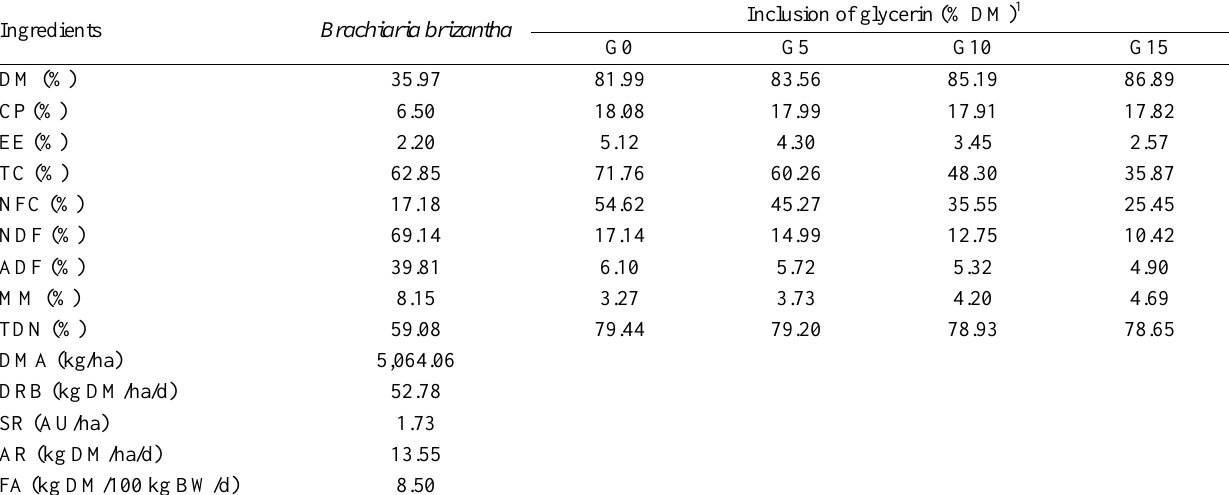
Table 2. Chemical composition of the Brachiaria brizanta cv. Marandu and of the concentrates (% of DM), total dry matter availability, residual biomass, stocking rate, accumulation rate and forage allowance